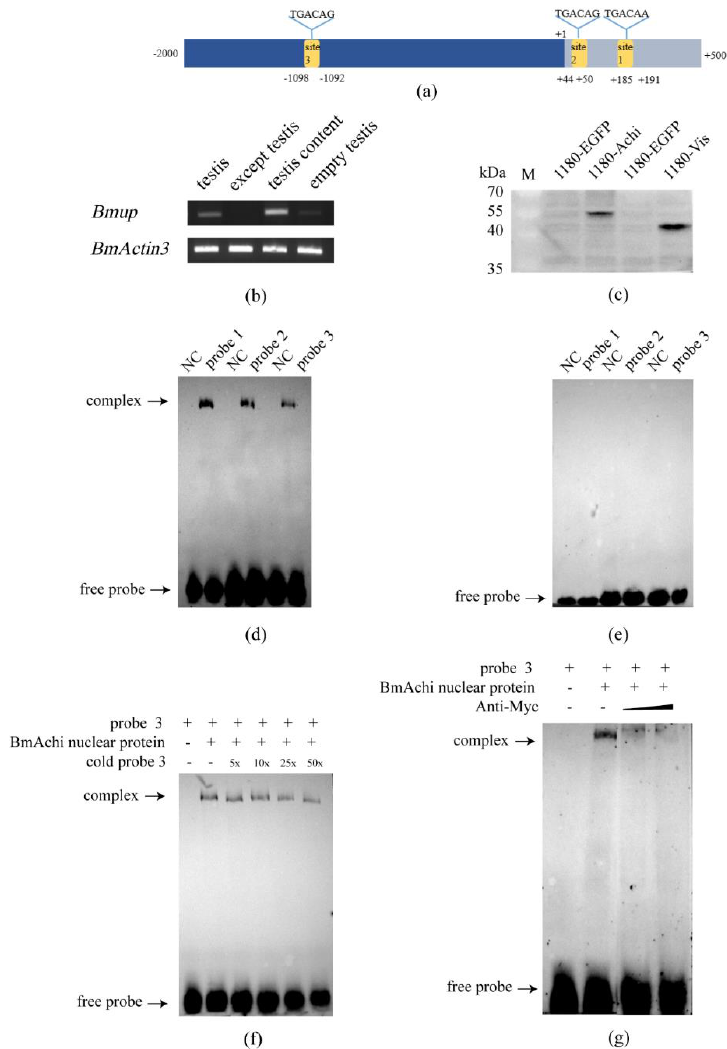
Figure 5. The binding of the transcription factor BmAchi and BmUP promoter. ( a ) Schematic diagram of the BmUP promoter. The yellow area represents the predicted binding site of the transcription factor BmAchi/BmVis, and the +1 position is the first base of BmUP . ( b ) Expression of BmUP in the testis; BmActin3 is an internal reference gene. ( c ) Western blot detection of BmAchi and BmVis protein; pSL1180-EGFP is a control. ( d , e ) Combination experiment of the BmUP promoter with BmAchi and BmVis. NC indicates only biotin-labeled probes in the system but no transcription fac- tor protein (lanes 1, 3 and 5). Probe 1, probe 2, and probe 3 represent the experimental groups in which the three probes react with nucleoprotein (lanes 2, 4 and 6). ( f ) EMSA cold competition ex- periment with the transcription factor BmAchi and probe 3. ( g ) EMSA super-shift experiment with the transcription factor BmAchi and probe 3.